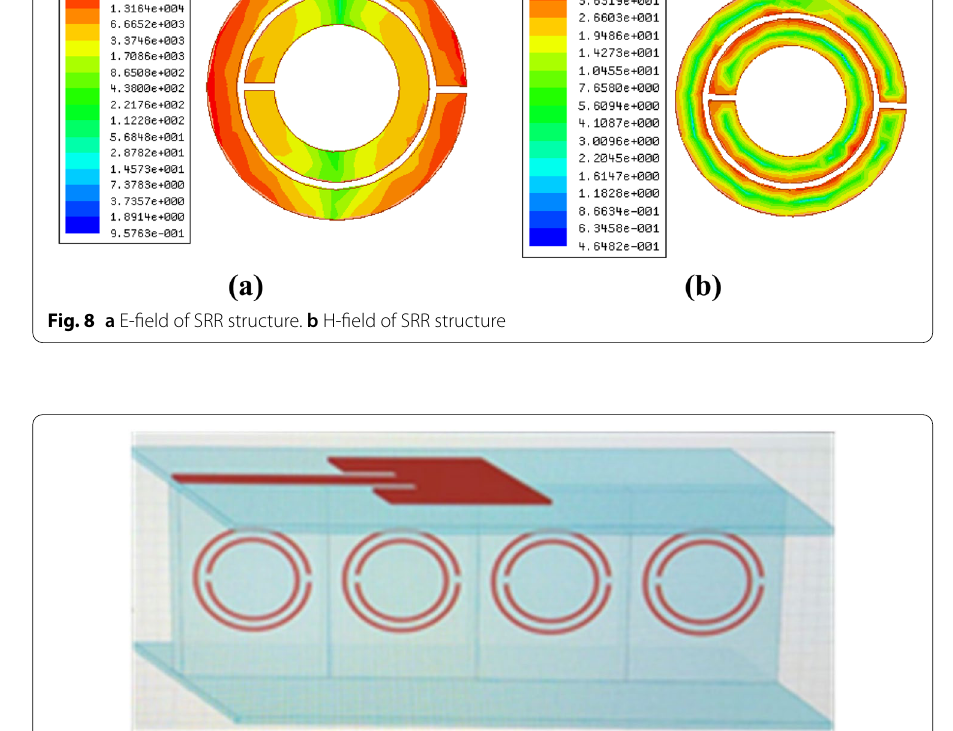
Fig. 9 Exploded view of proposed metamaterial (single layer)-embedded patch antenna in